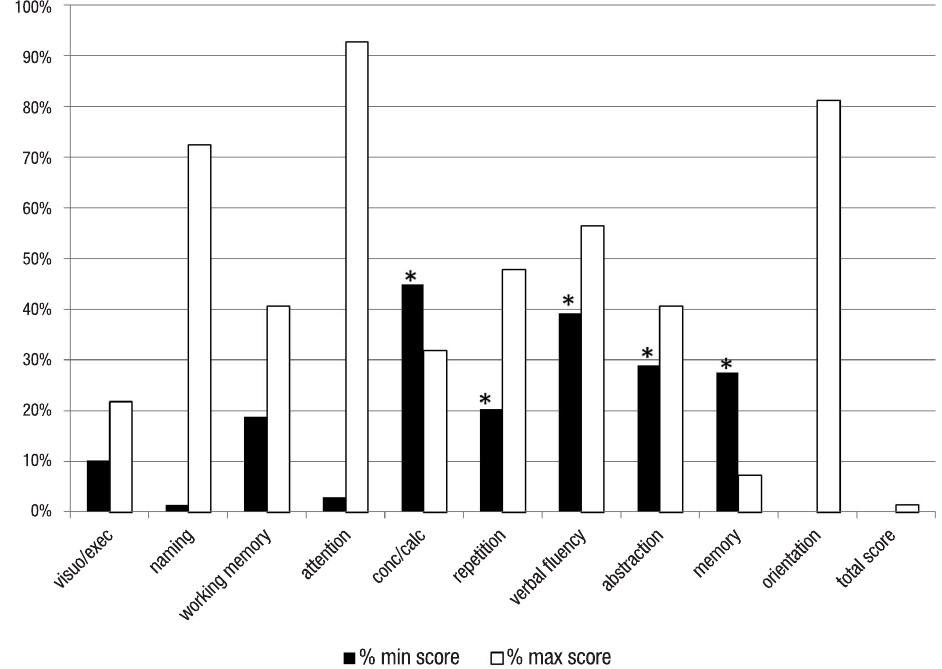
Figure 2. Graph showing percentage of minimum and maximum scores on the MoCA subtests: visuospatial/execu- tive abilities (0-5 points), naming (0-3 points), working memory (0-2 points), attention (0-1 point), concentration/cal- culation (0-3 points), repetition (0-2 points), verbal fluency (0-1 point), abstraction (0-2 points), short-term memory (0-5 points) and orientation to time and place (6 points). There was a significant floor effect in 5/10 of the MoCA subtests ( ≥ 20%). * ≥ 20% of patients obtained minimum scores on